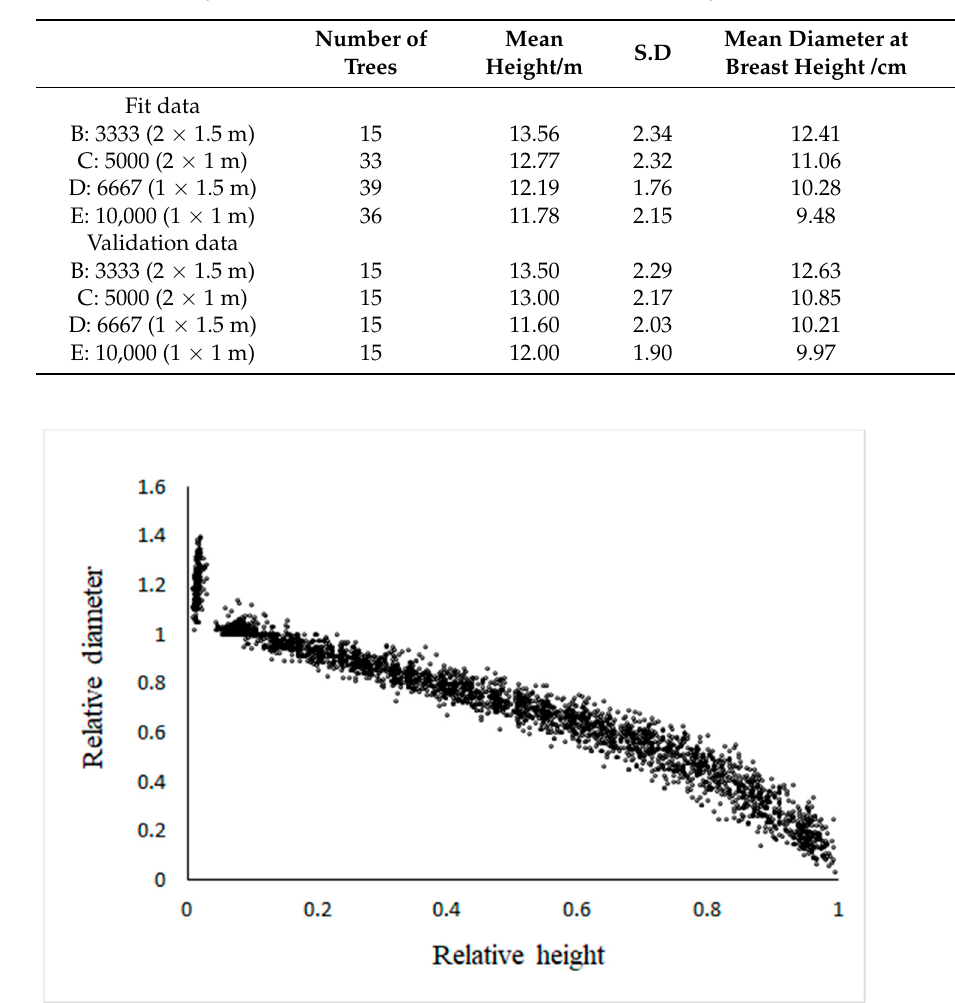
Figure 1. Relative height plotted against relative diameter of Chinese fir.